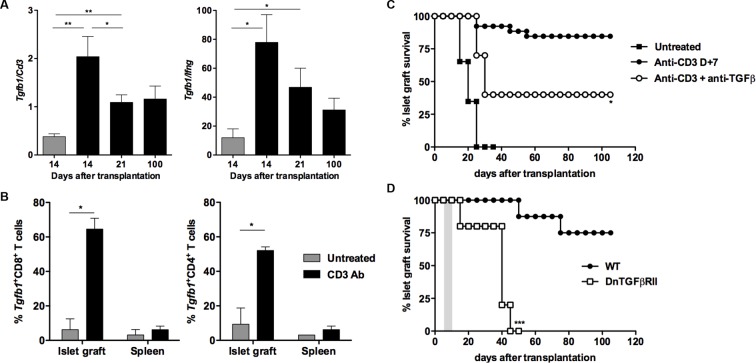
CD3 antibody-induced transplant tolerance depends on in situ TGFβ production and signaling in T cells.(A) Expression of Tgfb1 mRNA and evaluation of the Tgfb1/Ifng ratio in pancreatic islet allografts recovered at day 14 from untreated mice or day 14, 21 and 100 after transplantation from CD3 Ab-treated recipients. Data are shown as mean ± SEM of 5–9 individual samples (*p<0.05, **p<0.01). (B) Single cell PCR: individual CD4+ (n = 48) and CD8+ (n = 60) T cells were sorted on day +14 post-transplant from the spleen or islet allografts recovered from C57BL/6 mice treated or not with CD3 antibodies. Expression of Tgfb1 mRNA was measured in each cell. Results show the proportion of CD4+ and CD8+ T cells positive for Tgfb expression (*p<0.05). (C) Graft survival of BALB/c islets in wild-type C57BL/6 mice treated at day +7 with anti-CD3 F(ab’)2 and neutralizing TGFβ antibodies (1 mg/injection, twice a week for 3 weeks) (n = 4 to 8 per group, *p<0.05). (D) Abrogation of tolerance in DnTGFβRII C57BL/6 mice transplanted with BALB/c pancreatic islets and treated with CD3 antibodies on day7 post-transplant (n = 5 per group, ***p = 0.0002).